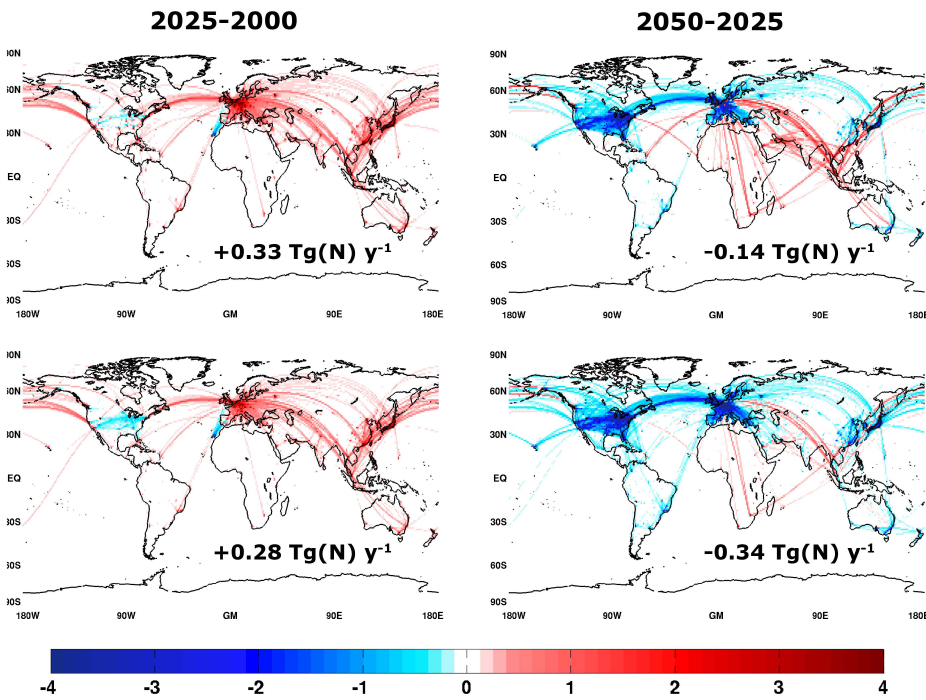
Fig. 2. Spatial distribution of the absolute difference in NO x emission flux from aircraft for the B1 (top) and B1 ACARE (bottom) scenarios (unit: 10 13 1 molecules NO 2 m − 2 s − 1 ) used in QUANTIFY.